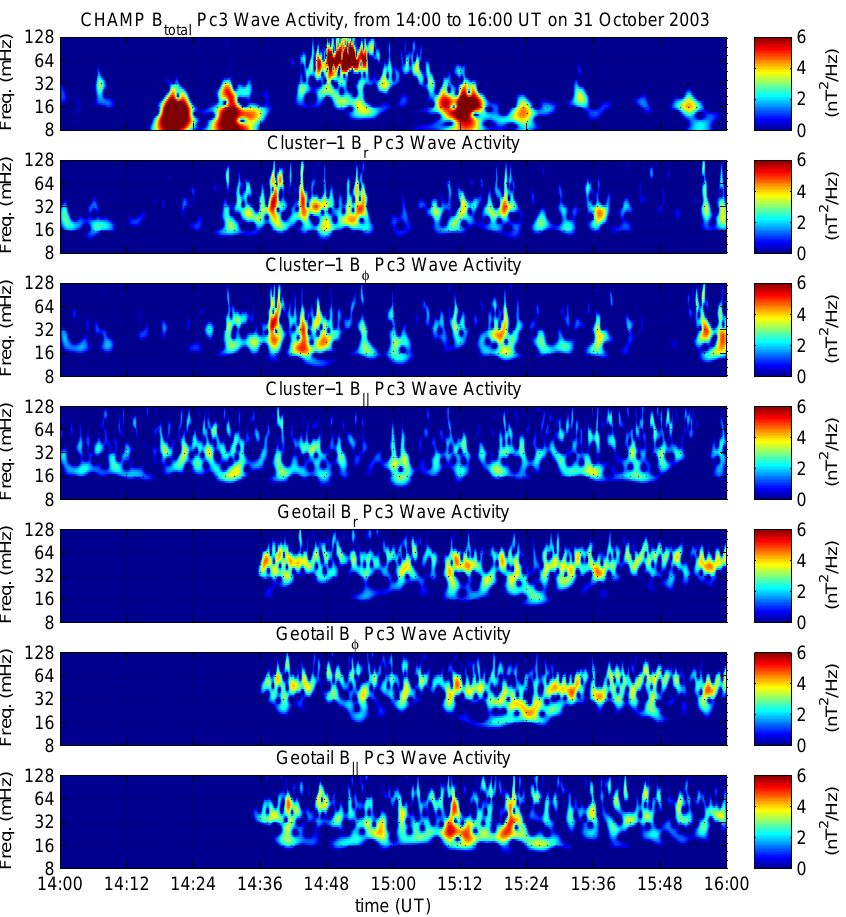
Fig. 11. Event 2: 14:00–16:00UT, 31 October 2003. From top to bottom are shown the wavelet power spectra of the Pc3 ULF wave activity from CHAMP total magnetic field, Cluster-1 poloidal, toroidal and compressional components as well as Geotail MFA components.